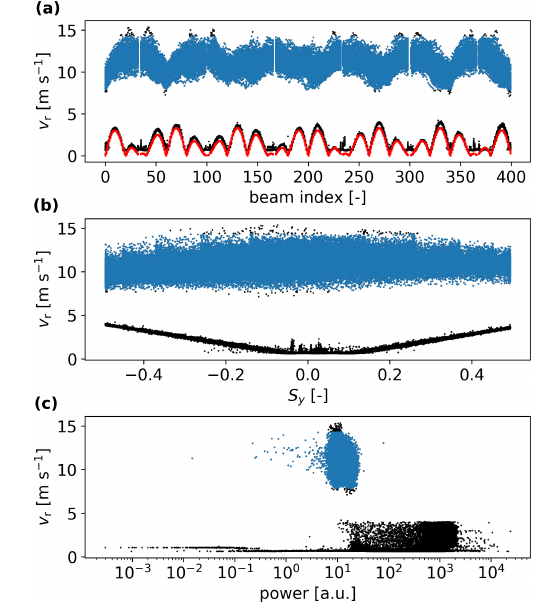
Figure 5. Radial velocity as function of (a) index of the 400 beams in each full scan, (b) the lateral component of the unit vector S y and (c) power for an arbitrary 10min period. Filtered data are shown in black and data left after filtering in blue. The red color in the top panel represents the simulated radial velocity from the possible blade